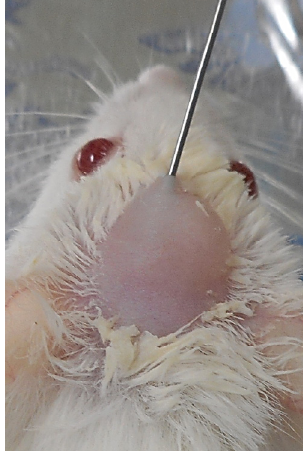
Figure 4. Subcutaneous injection of SG I*nHAp (+) = x-tHyA + BMP + nHAp sample in sol stage into the mouse cranial area.